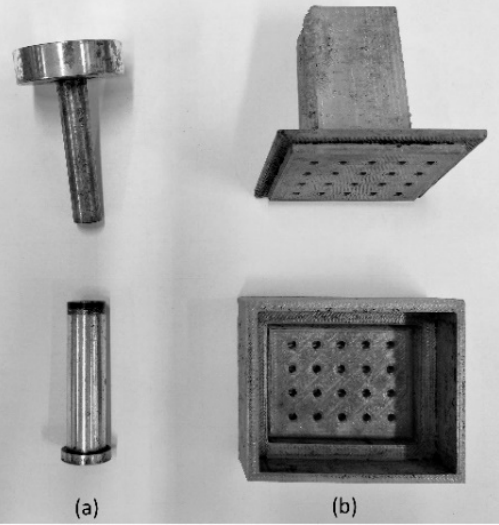
Figure 2. Molds and stamps for the pressing of cylindrical ( a ) ø 10 mm and planar monoliths ( b ) 50 × 40 × 5 mm.